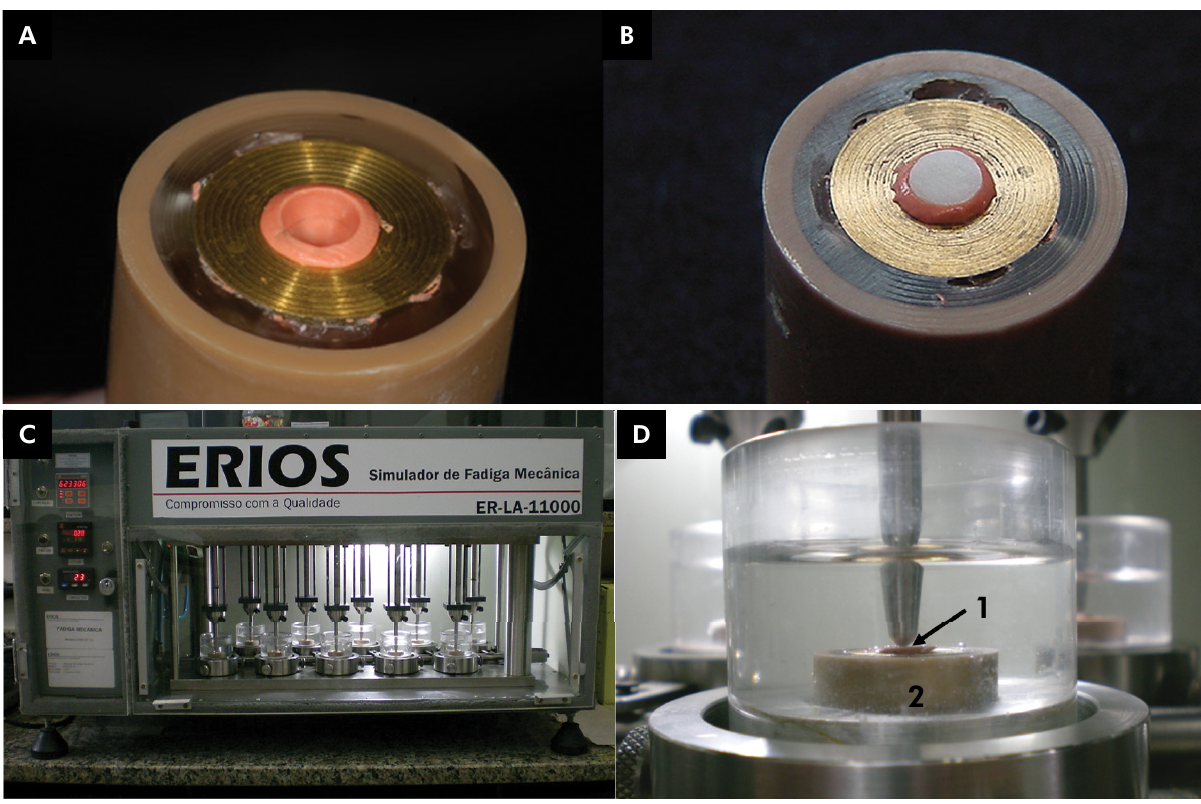
Figure 4. Joinable receptacle for strength fatigue simulator (a), positioned cement specimen at the receptacle (b), Erios mechanical cycle fatigue simulator (c) and specimen during mechanical fatigue. The black arrow indicated the cement disk position, 1 the receptacle is indicated by 2.